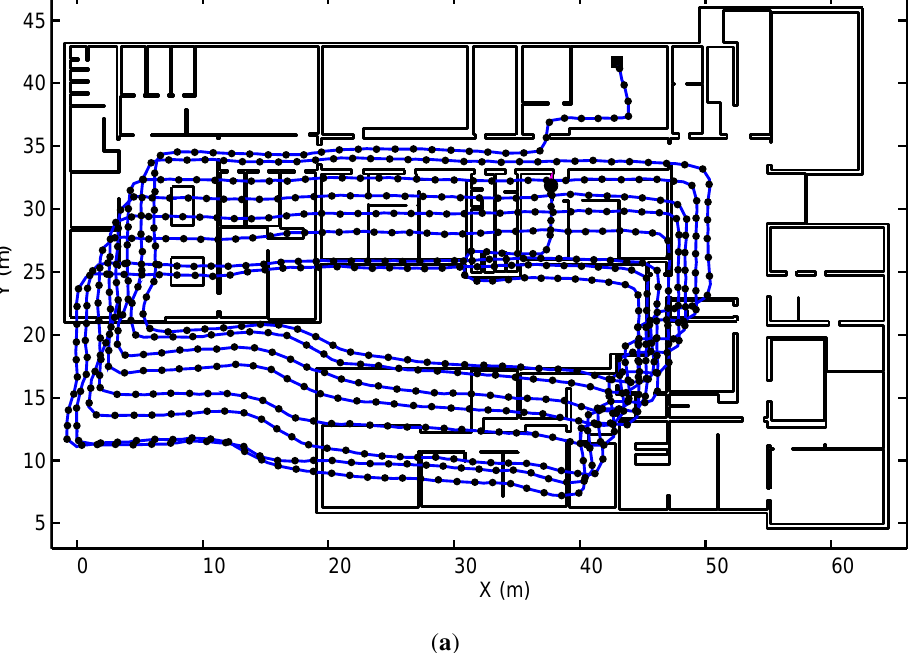
Figure 7. Closed route repeated 8 times, for a trajectory with a total length of 1 km.